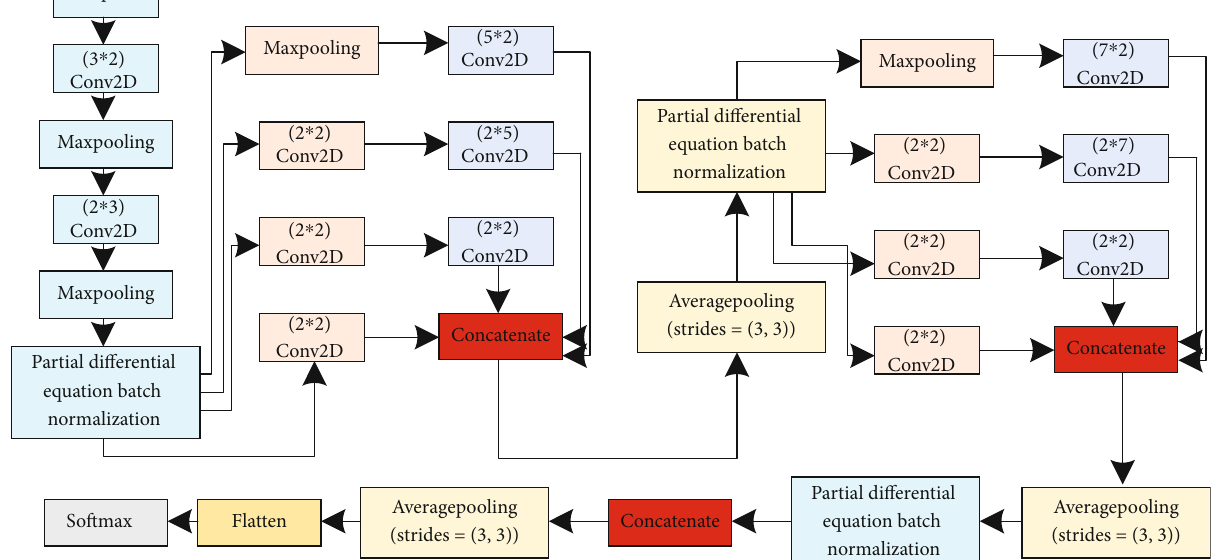
Figure 3: Inception-based partial di ff erential equation neural network structure.